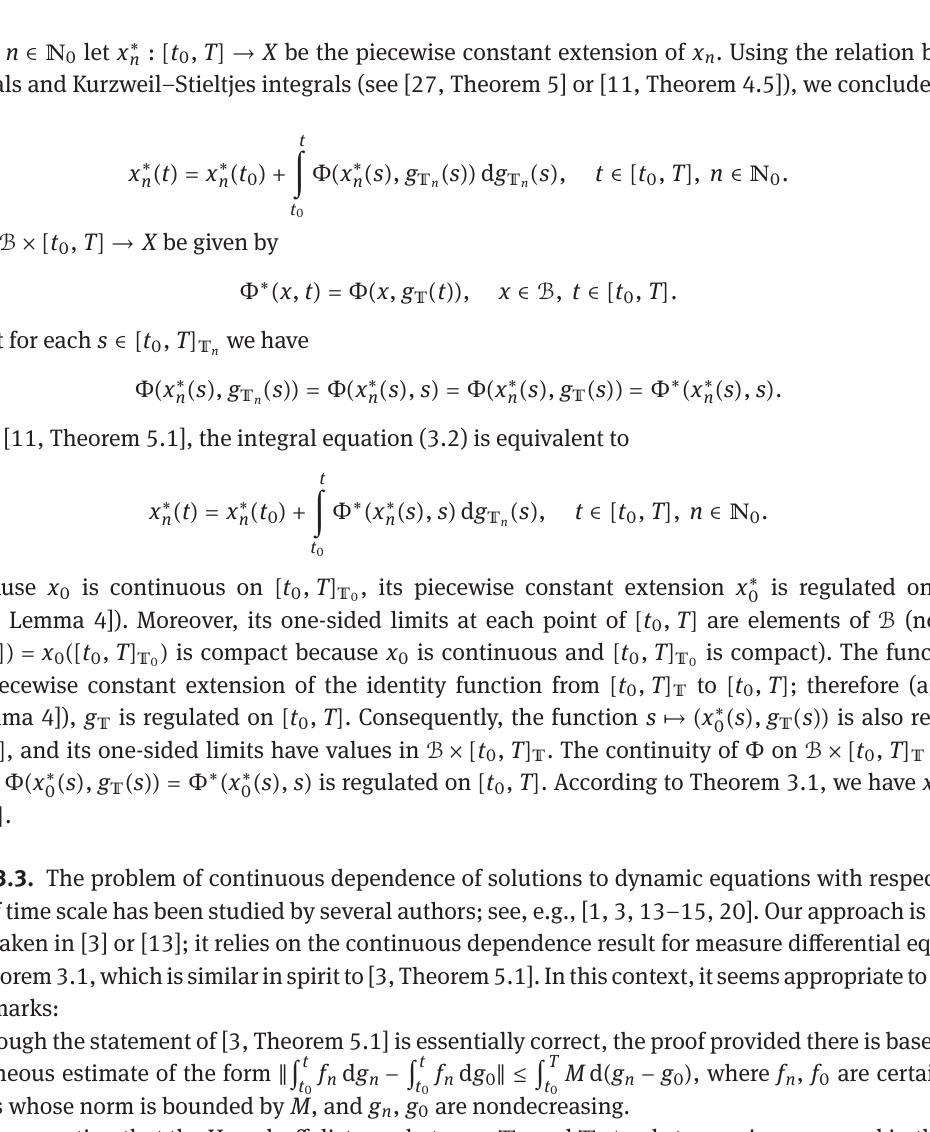
Figure 1: The piecewise constant extension x ∗ (gray) of a function x (black); see (3.1)